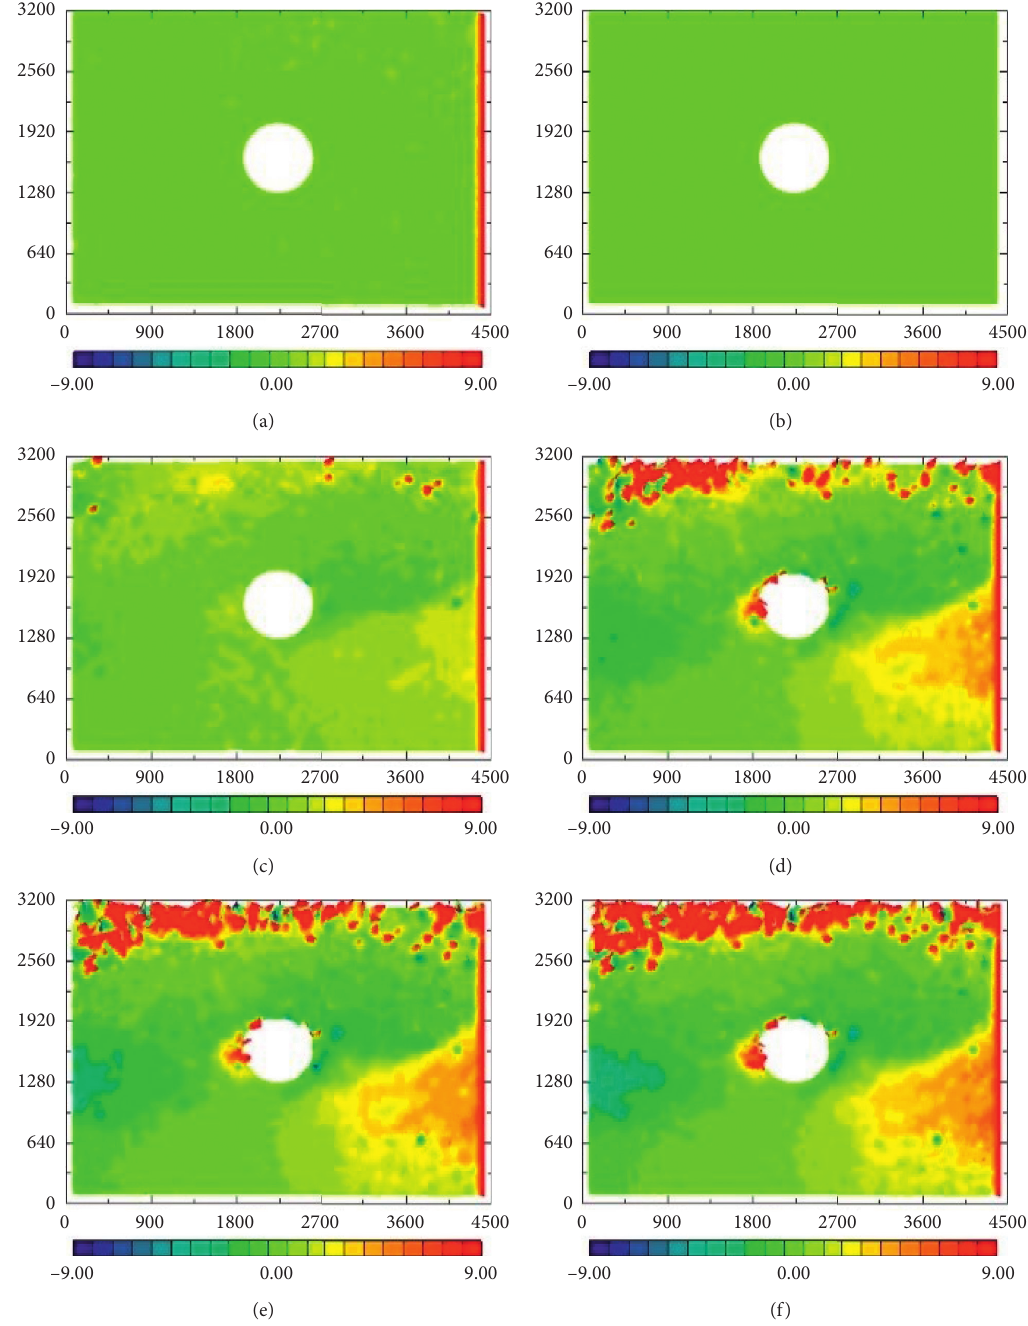
Figure 18: Horizontal displacement cloud map with support model. (a) 0.25 MPa. (b) 0.32MPa. (c) 0.48 MPa. (d) 0.58MPa. (e) 0.63MPa. (f)